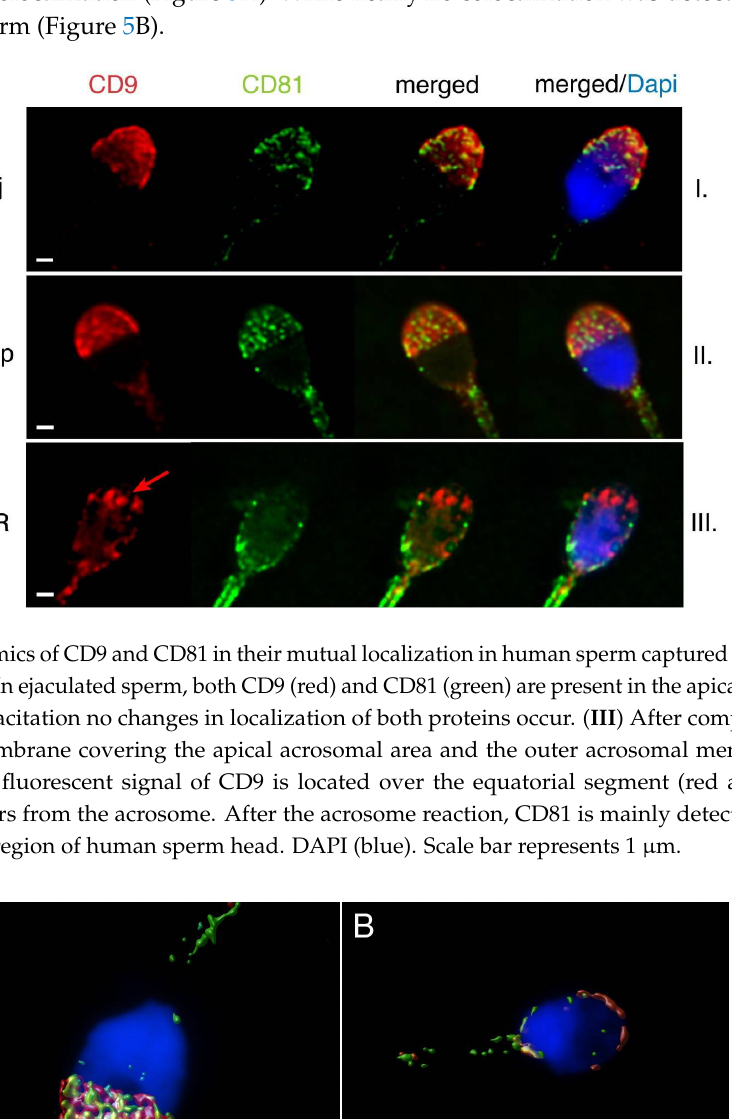
Figure 5. Surface rendering of colocalization map of CD9 and CD81 in human ejaculated and acrosome reacted sperm. Confocal images and Huygens software were used for better visualisation of colocalization area (yellow) for CD9 (red) and CD81 (green). ( A ) Ejaculated human sperm shows a high rate of colocalization of CD9 and CD81 in the acrosomal cap. ( B ) In case of acrosome reacted sperm, CD9 remains to be present in the inner acrosome membrane, however CD81 is hardly detectable across the sperm head. DAPI (blue). Scale bar represents 2 ( A ) and 3 ( B ) μm.